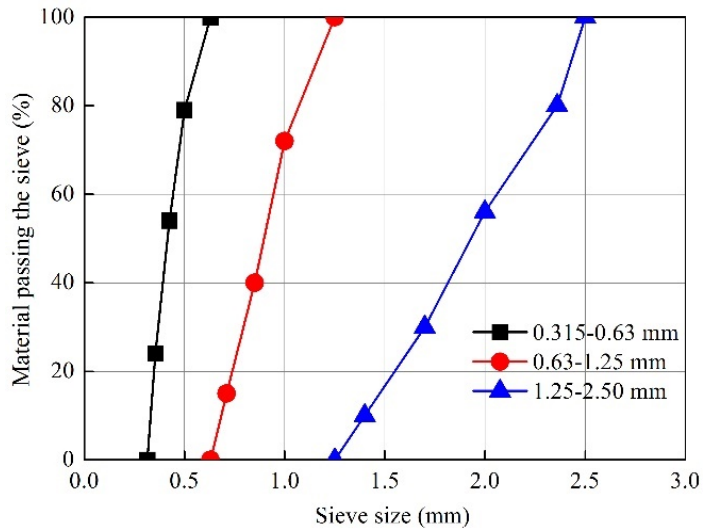
Figure 1. Sand gradations.